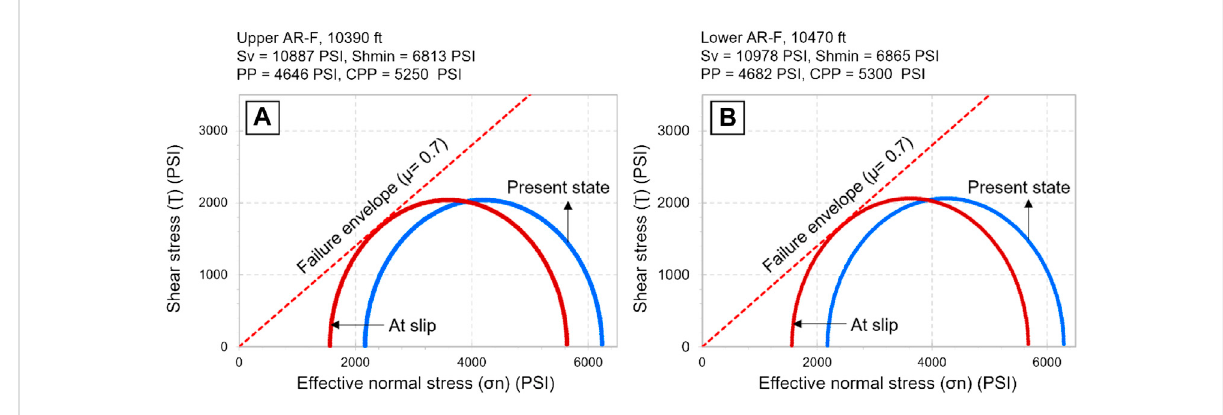
FIGURE 6 Criteriaforshearslippageonarandomlyorientedweakplaneat (A) UpperAR-Fand (B) LowerAR-Fintervals.CPPdenotescriticalporepressure for a slip to